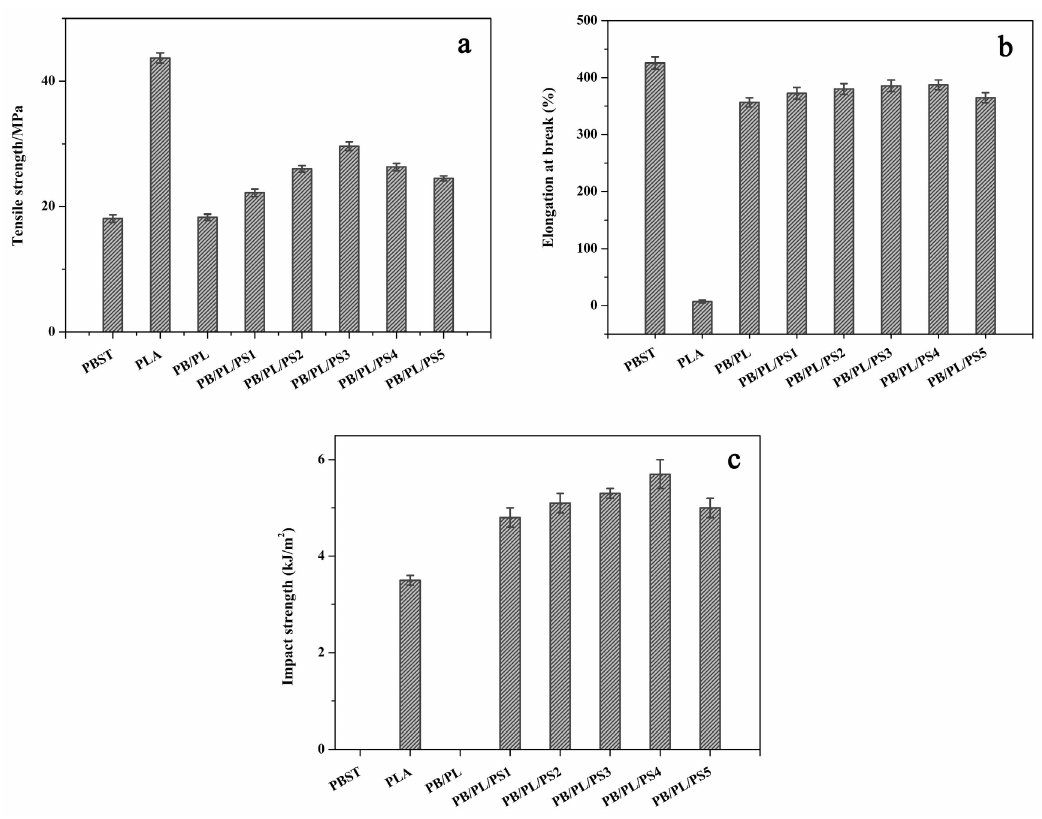
Figure 5. Mechanical properties of neat PBST, PLA, and PBST/PLA blends with various amounts of PSMA: ( a ) tensile strength, ( b ) elongation at break, and ( c ) impact